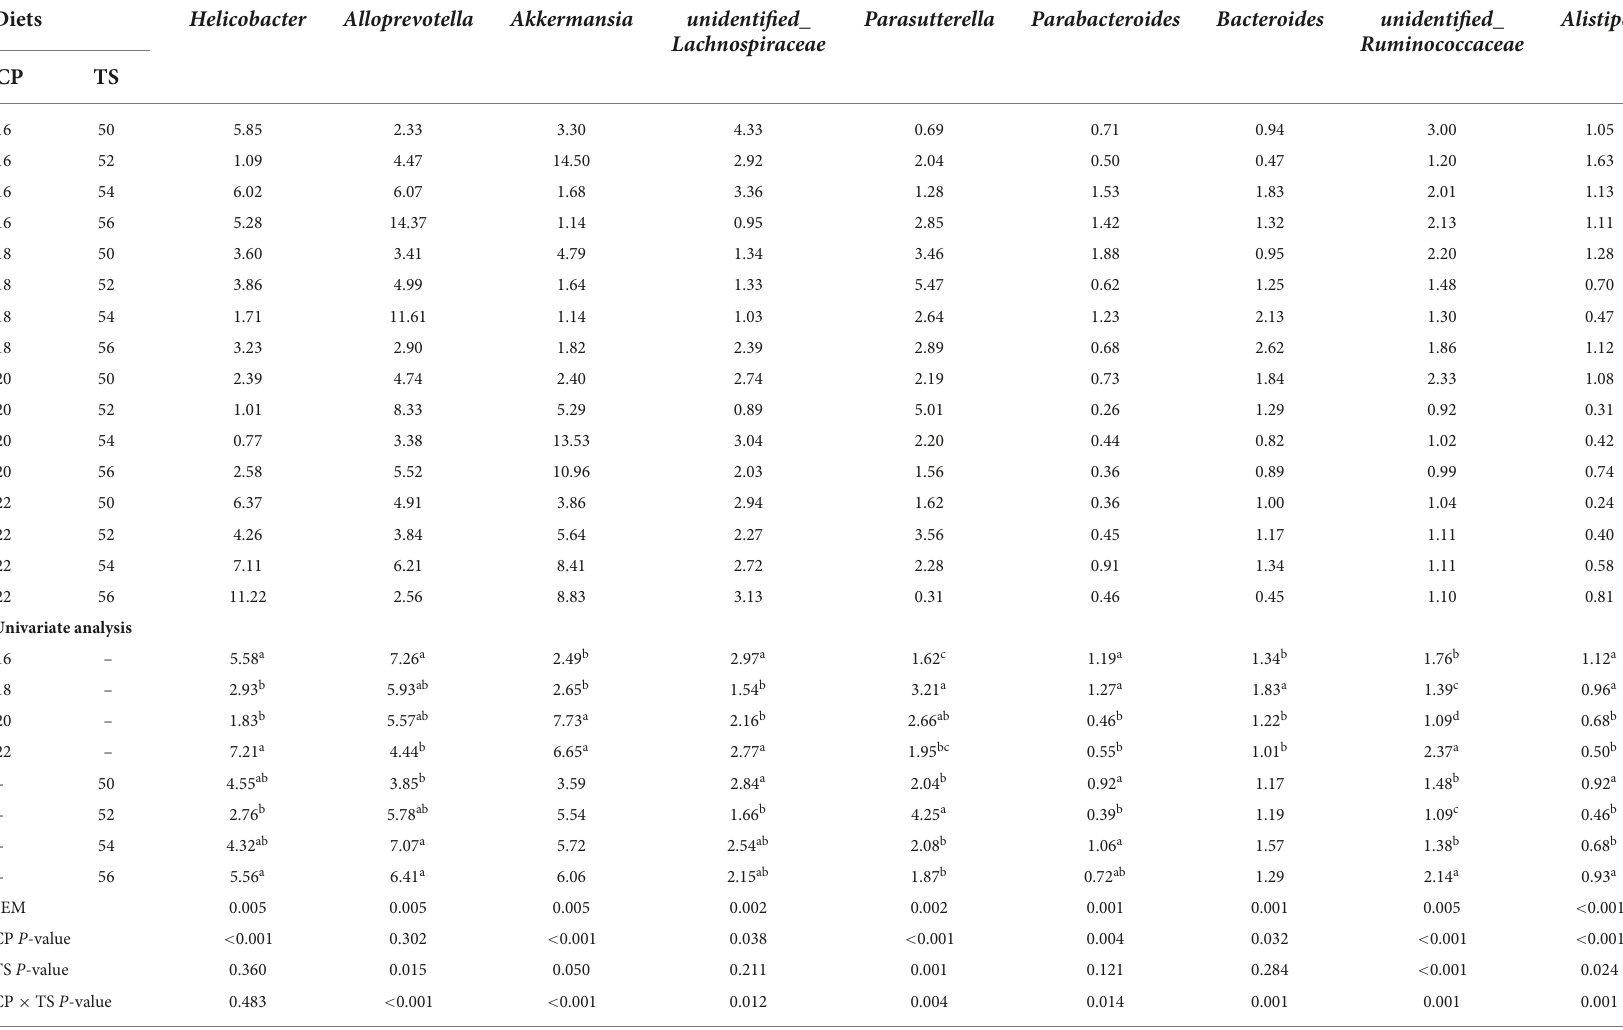
TABLE 3 Genus-level composition ( > 1%) on the fecal bacterial community of mice fed different starch and protein ratio